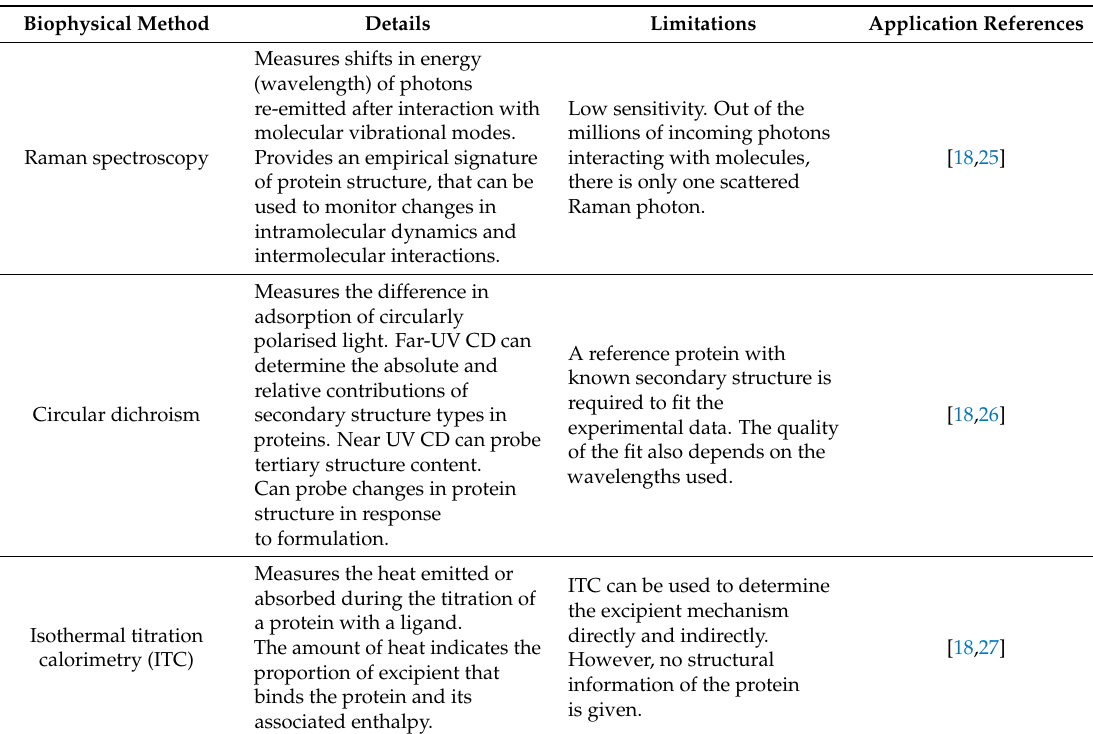
Table 1. High throughput biophysical methods used for excipient